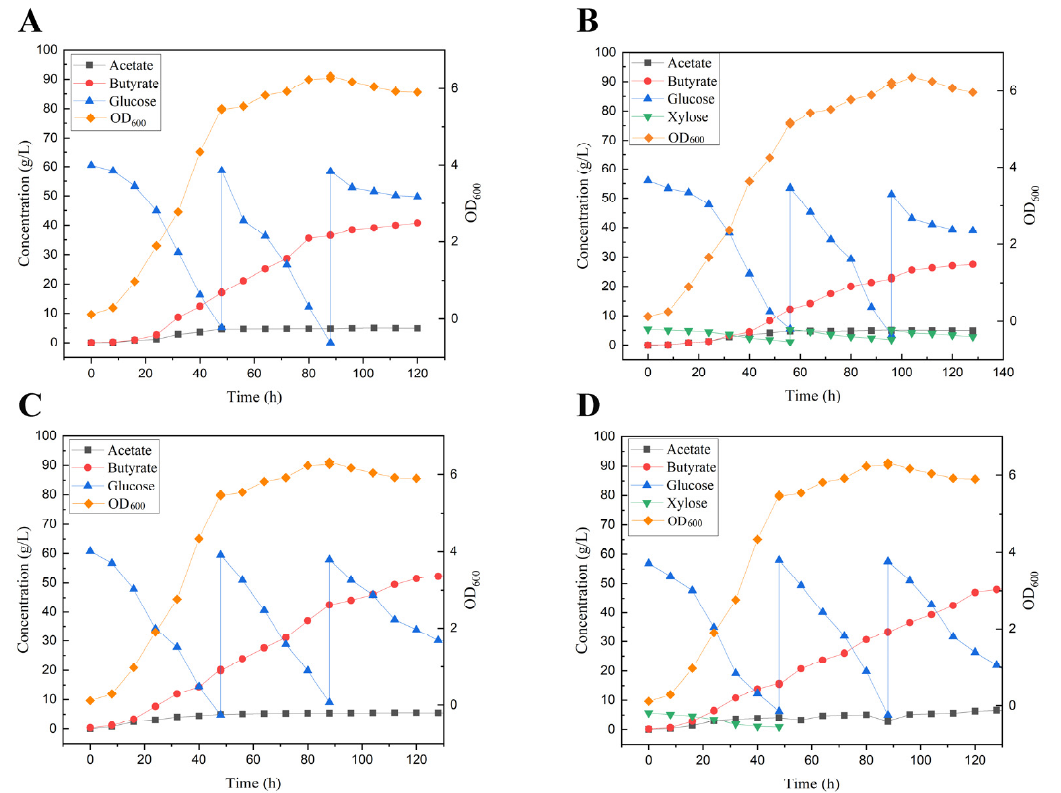
Figure 5. Performance of butyric acid production fed with glucose and hydrolysate in batch mode. ( A , C ) show the fermentation fed with glucose in the free-cell and immobilized-cell modes, respectively, for butyric acid production. ( B , D ) show the fermentation fed with hydrolysate in the free-cell and immobilized-cell modes, respectively, for butyric acid production.